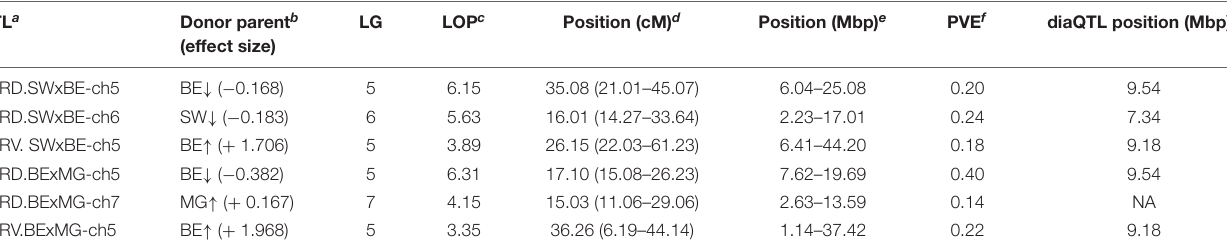
FIGURE 2 | Linkage maps of two tetraploid garden rose mapping populations, Stormy Weather × Brite Eyes (SWxBE) and Brite Eyes by My Girl (BExMG) aligned to the Rosa chinensis reference genome (Hibrand-Saint Oyant et al., 2018). The genomic physical positions are plotted on the y -axis, and the genetic position (cM) is plotted on the x -axis. TABLE 3 | Quantitative trait loci (QTL) for rose rosette disease and Rose rosette emaravirus resistance in two tetraploid garden rose biparental mapping